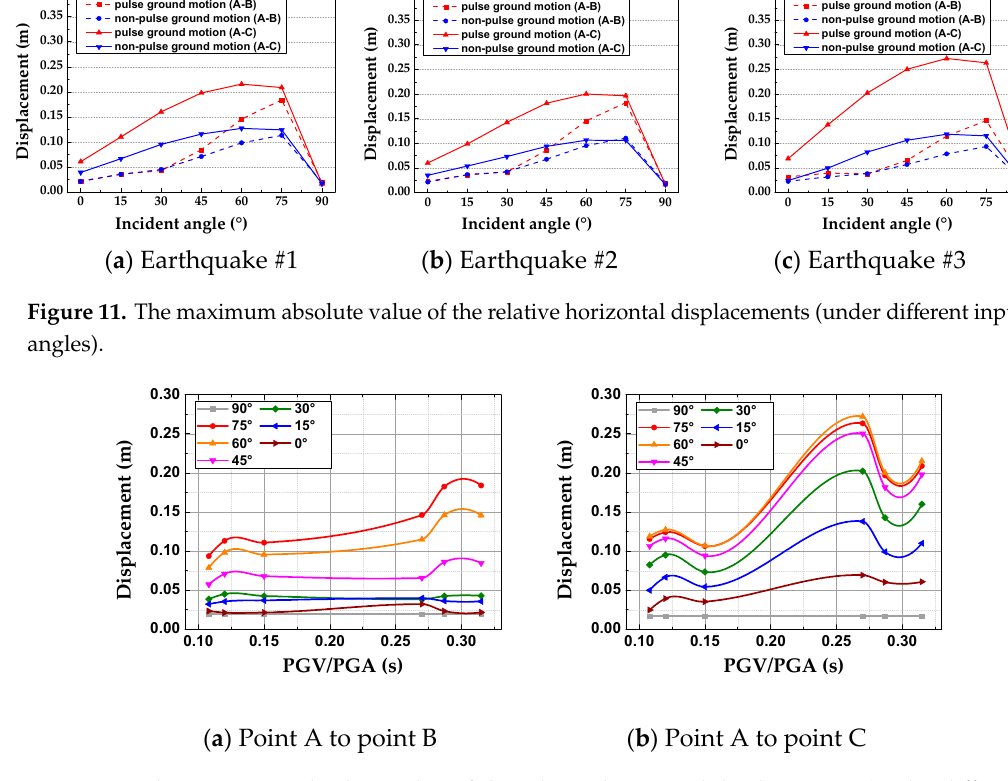
Figure 12. The maximum absolute value of the relative horizontal displacements (under different PGV/PGA ratio).